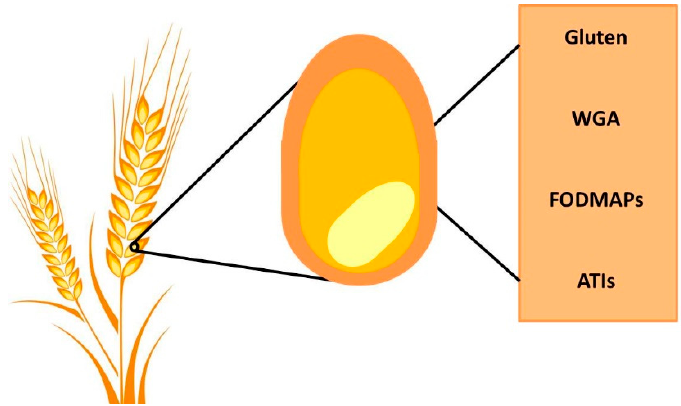
Figure 1. Wheat components. Gluten is the most abundant protein in wheat, but there are also other important components: wheat germ agglutinin (WGA), fermentable oligosaccharides, disaccharides, monosaccharides and polyols (FODMAPs) and α -amylase/trypsin inhibitors (ATIs).